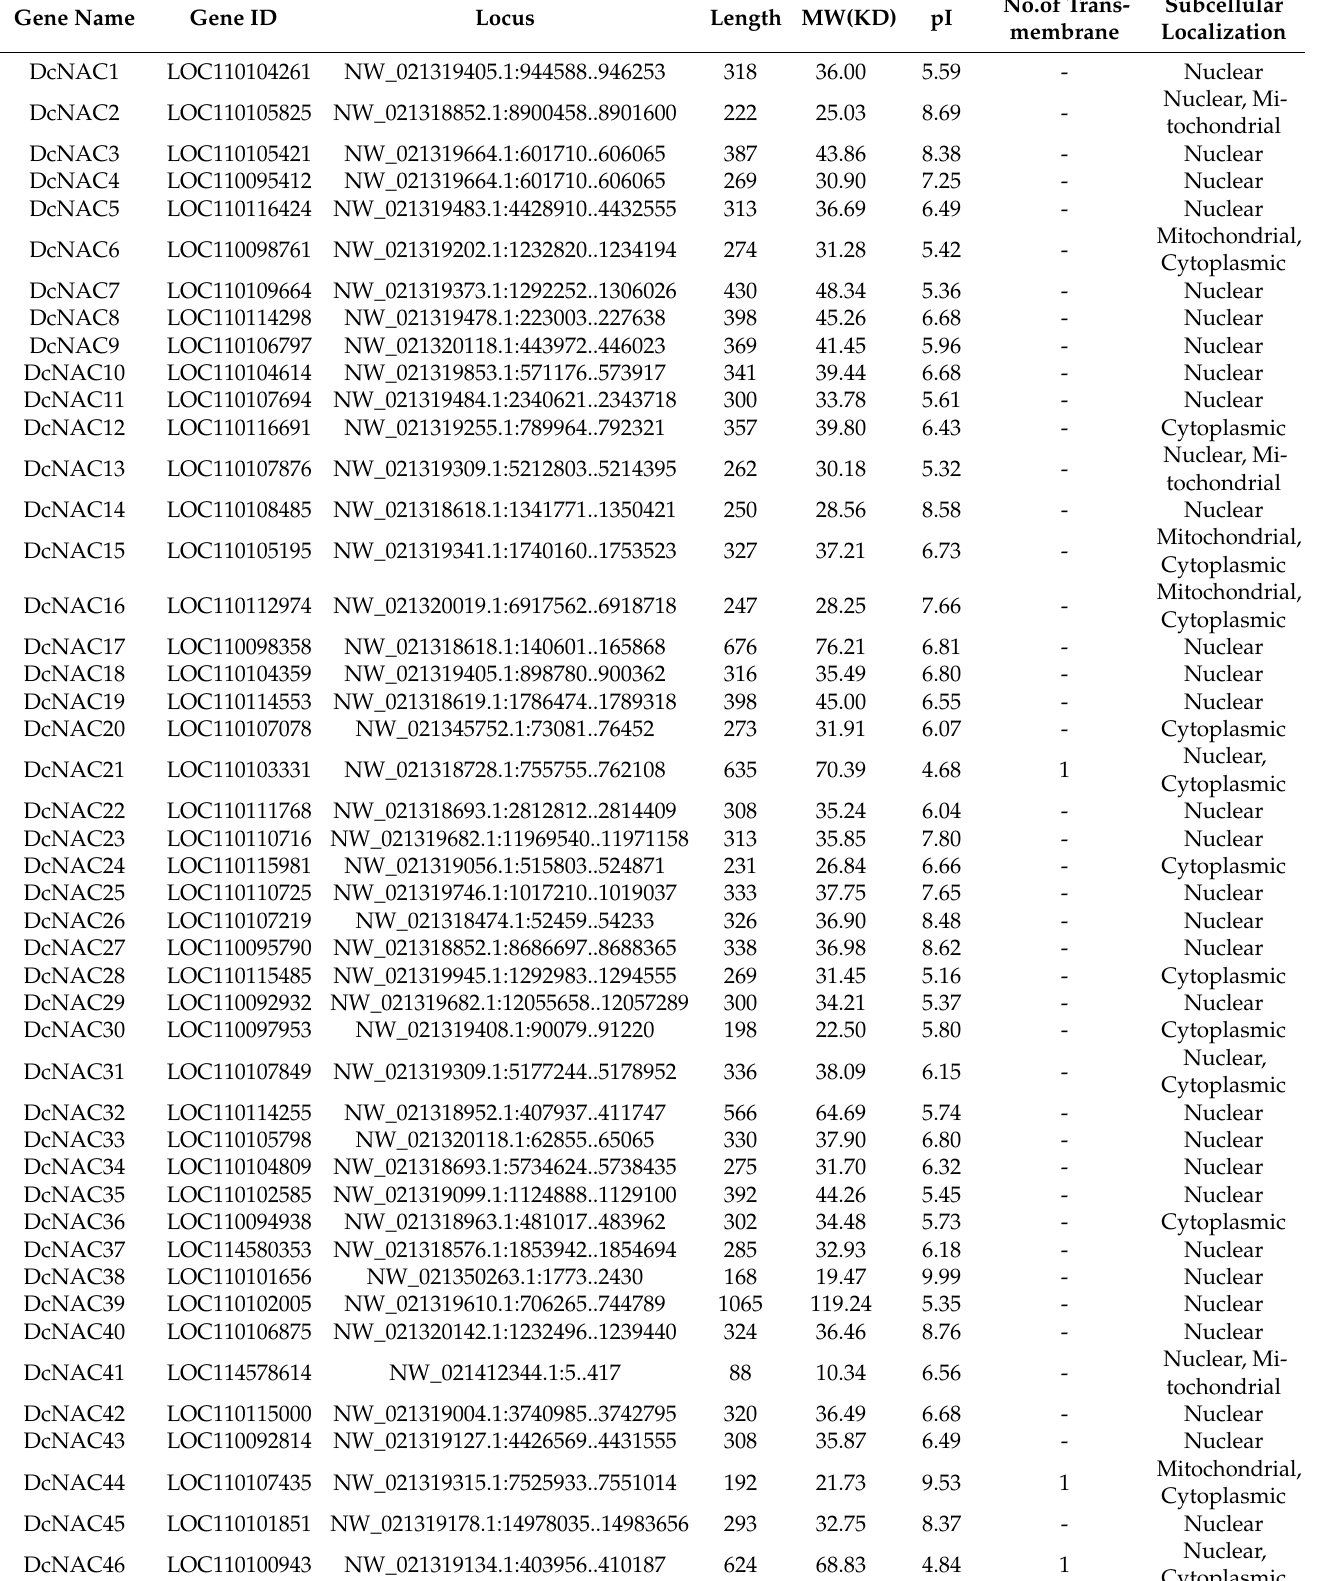
Table 1. Physicochemical properties of D. catenatum NAC